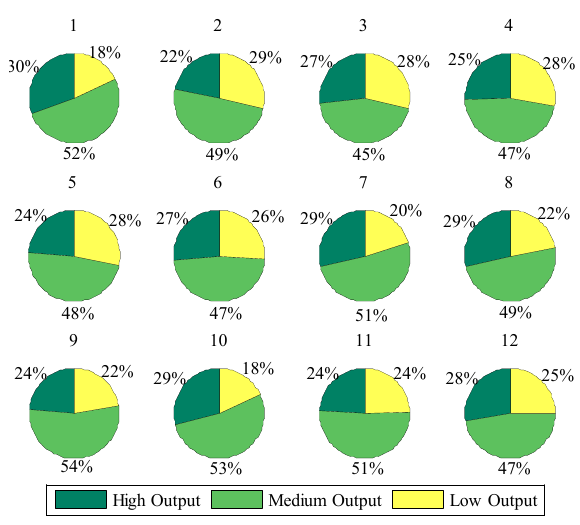
Figure 1. The output level of each month of PV power plant.